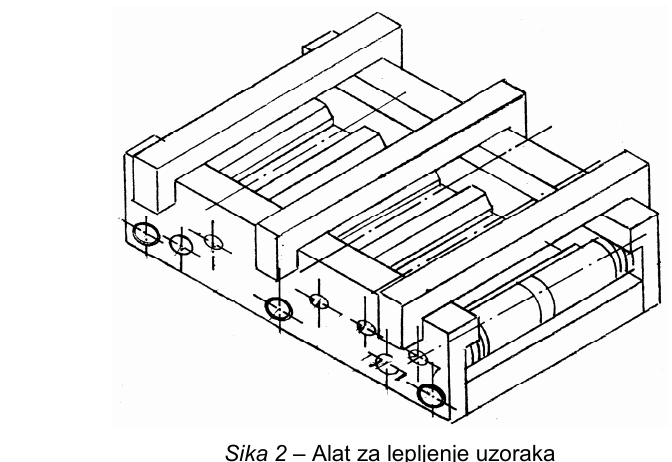
Figure 2 – Tool for gluing specimens